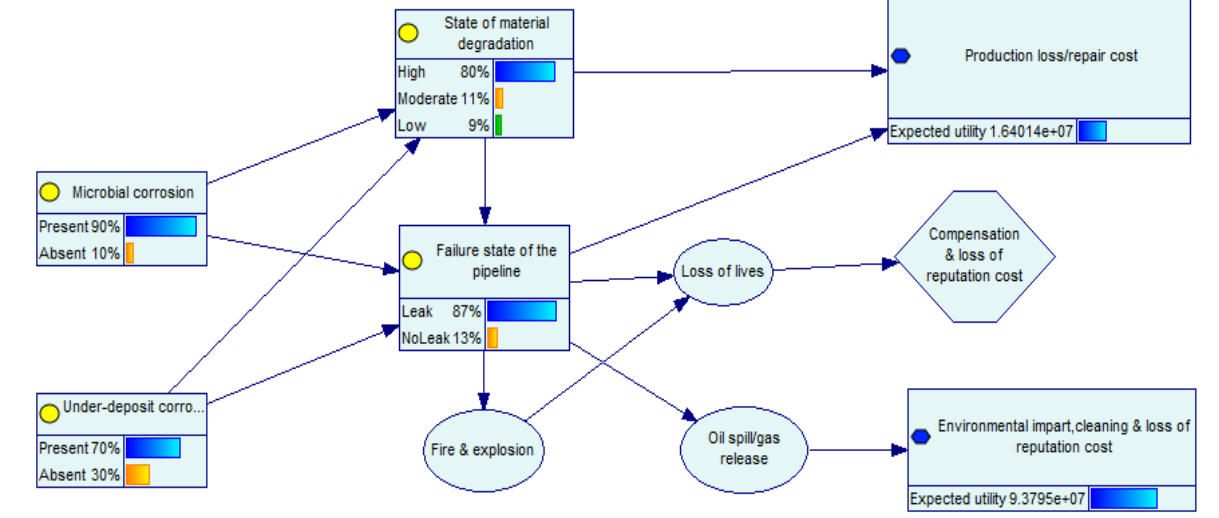
Figure 2. Parametric learning of the BPN model for economic loss prediction.